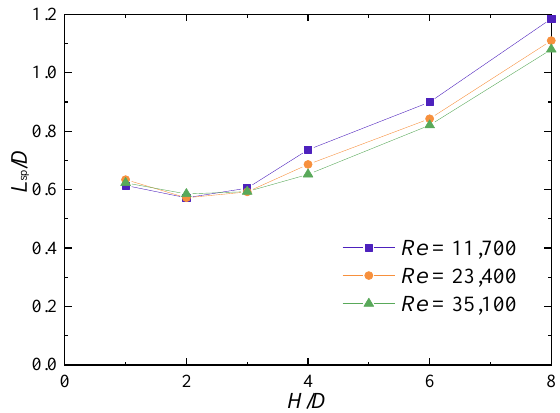
Figure 12. Normalized distance L sp /D between SP and GC. To explore the velocity distribution in the near-wall region, Figures 13 and 14 show the horizontal distributions of |V z |/V b and V x /V b ( Re = 35,100) at different locations ( z/D =